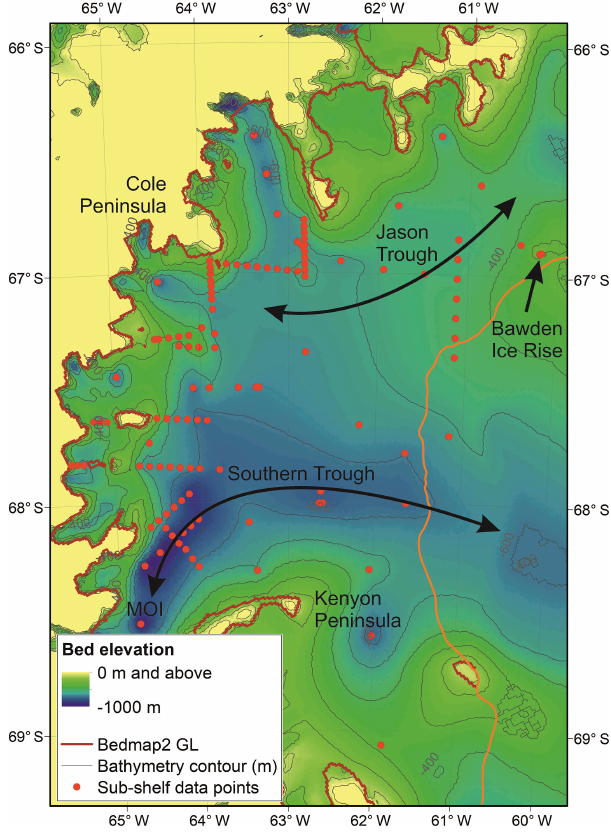
Figure 3. Updated bathymetry map of Larsen C Ice Shelf with large-scale features highlighted. For clarity, elevations above 0m are unscaled, and we label only the − 400 and − 600m contours. The brown line represents the Bedmap2 grounding line (GL) (Fretwell et al., 2013). The orange line represents the ice front on 20 De- cember 2018, highlighting the new ice front following the calving of iceberg A68 determined from MODIS imagery (Vermote and Wolfe, 2015). MOI – Mobiloil Inlet. The black arrows highlight likely oceanographic conduits, as discussed in the